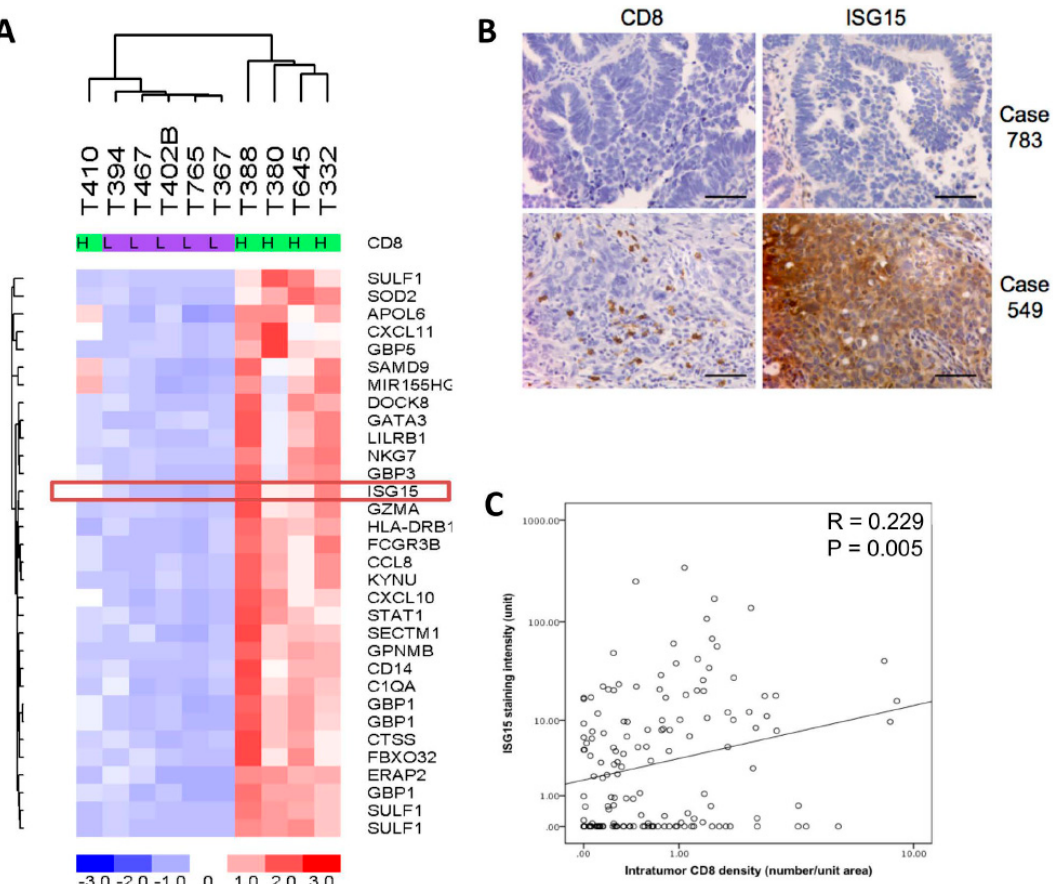
Figure 1. Interferon-stimulated gene 15 (ISG15) protein expression level is associated with intraepithelial CD8+ T lymphocyte density in high grade serous ovarian cancer (HGSOC). ( A ) Transcription profiling analysis on five microdissected HGSOC tissue samples with high density of intraepithelial CD8+ T lymphocyte and five samples with low density of intraepithelial CD8+ T lymphocyte showed that ISG15 expression levels is significantly higher in HGSOC samples with high intratumoral CD8+ cell densities when compared to those of the low intratumoral CD8+ cell densities. ( B , C ) Immunolocalization of ISG15 and CD8+ tumor infiltrating lymphocytes in 150 HGSOC samples showed a significant positive correlation between numbers of intratumoral CD8+ lymphocytes and ISG15 expression. (Bar = 100 μ m).